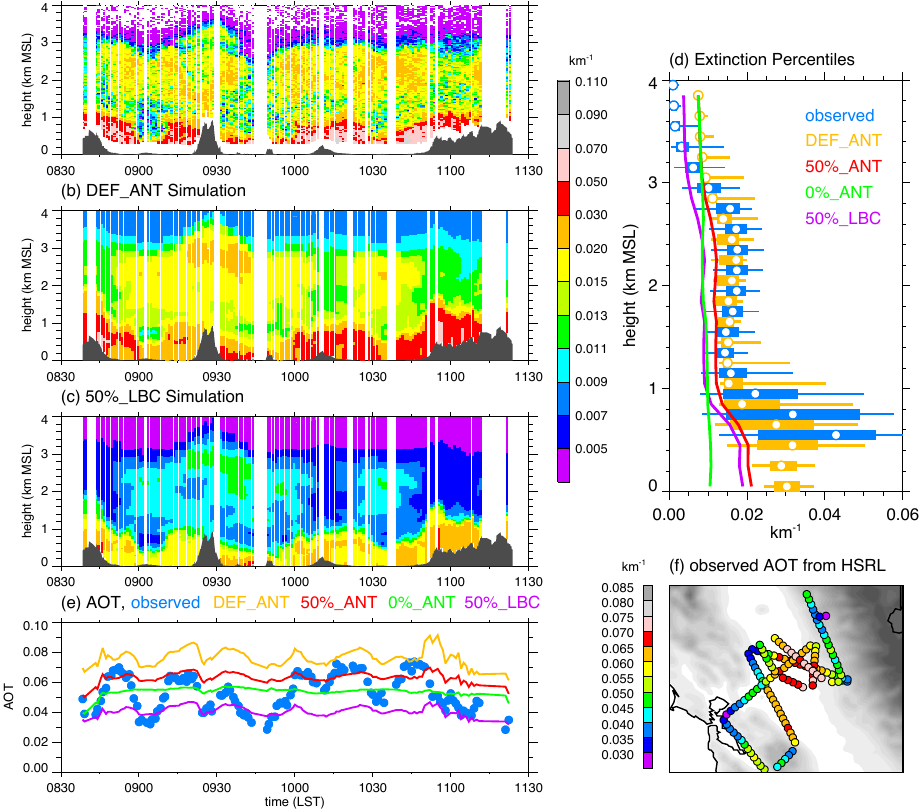
Figure 25. (a) Observed extinction along the B-200 aircraft flight in the vicinity of Sacramento on 27 June and the corresponding simulated profiles from (b) DEF_ANT and (c) 50%_LBC. (d) Percentiles of extinction as a function of altitude over the entire flight binned for the observations and DEF_ANT simulation, where vertical lines denote 50th percentiles from the 50%_ANT, 0%_ANT, and 50%_LBC simulation. (e) Observed and simulated column integrated AOT obtained from the extinction profiles along the flight path shown in (f)